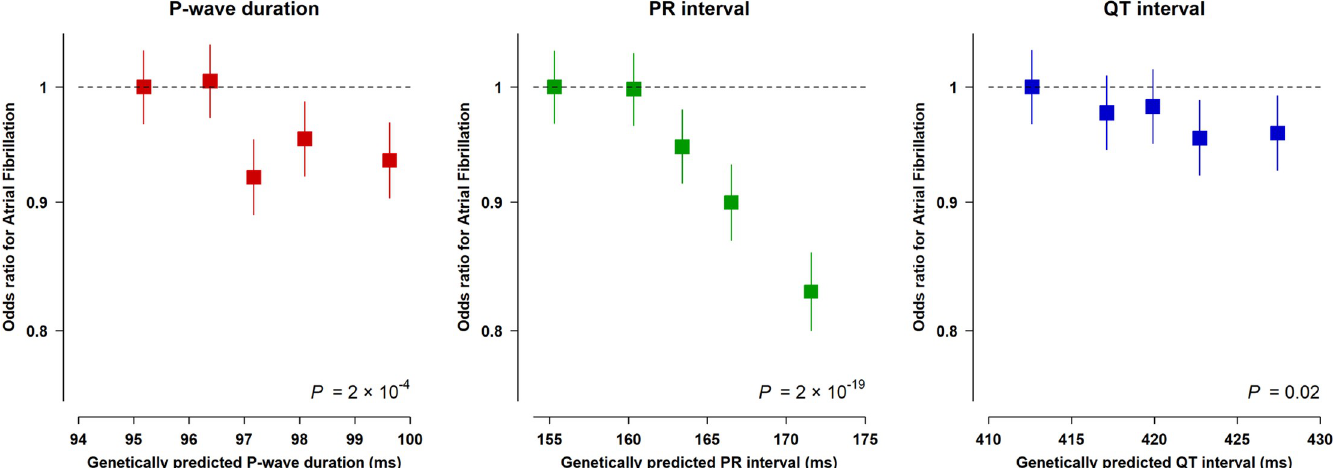
Fig 2. Effects of genetically predicted ECG parameters on risk of AF in UK Biobank. ORs for AF per quintile of genetic score (defined in non-AF cases) in 278,792 participants in UK Biobank. Boxes represent effect estimates with their size inversely proportional to variance. Solid lines represent 95% CIs calculated using floating absolute risks. ORs are adjusted for genotyping array, sex, and 40 principal components of ancestry. P calculated across continuous genetic score values adjusting for sex, genotyping array, and 40 principal components of ancestry. AF, atrial fibrillation; CI, confidence interval; OR, odds ratio.